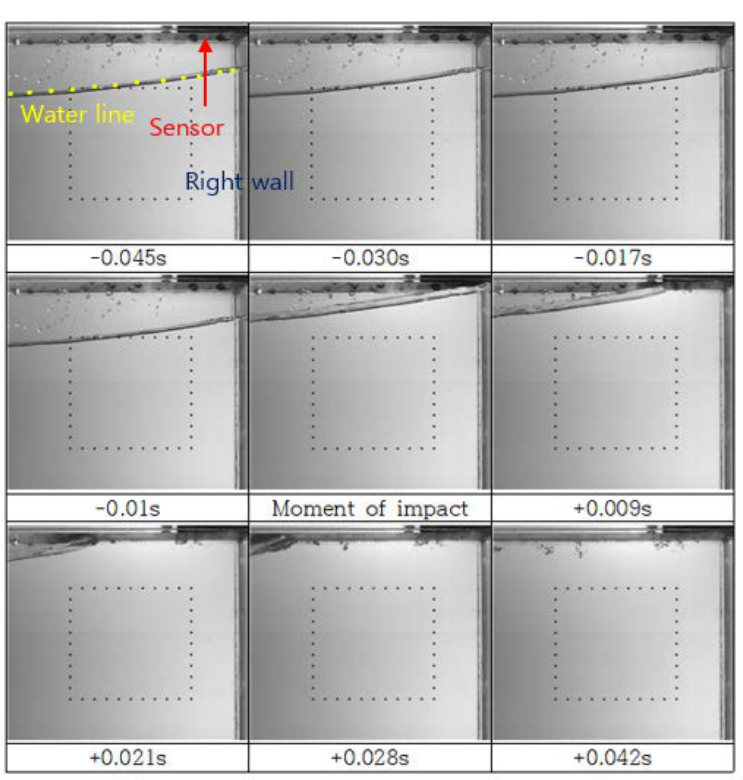
Figure 11. Snapshots of Flow: ROLL (Wet).